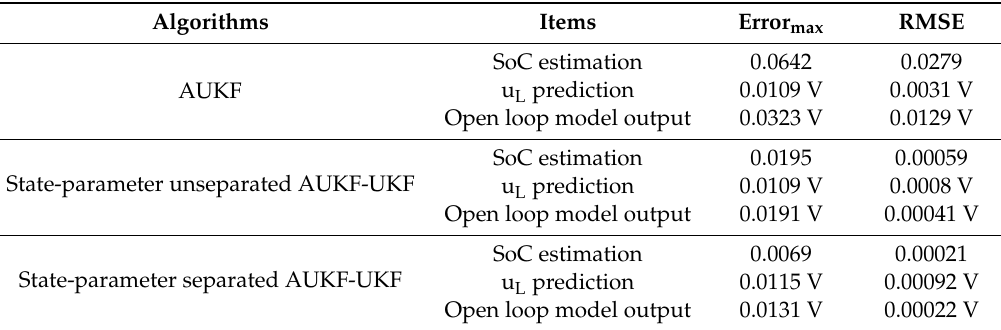
Figure 17. ( a ) The comparison of the open-loop output between three algorithms under DST test; ( b ) The comparison of the open-loop output error between three algorithms under DST test. Table 5. Error analysis of di ff erent algorithms under DST